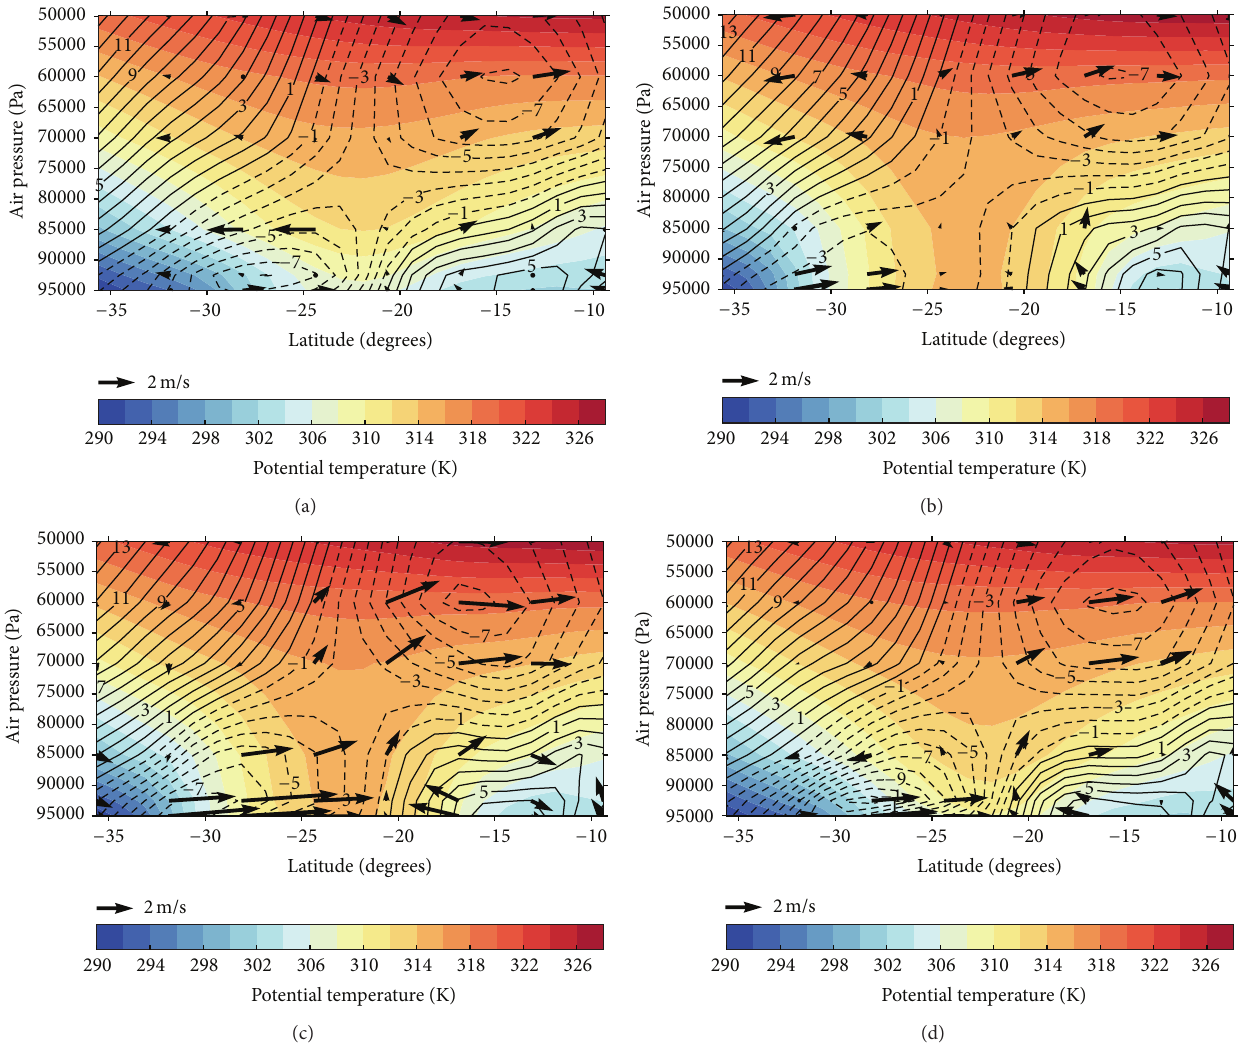
Figure 3: Climatological mean (1979–2001) potential temperature (K), horizontal and vertical wind (ms −1 ) along 125 ∘ E in A1.0 at (a) 0800 AWST,(b)1400 AWST,(c)2000 AWST,and(d)0200 AWST.Thecolorsindicatepotentialtemperatureandtheblackcontoursindicatethe zonal winds, respectively. The dotted and solid black lines represent zonal flow into and out of the page, respectively. The vertical component is multiplied by a factor of 100 to make it